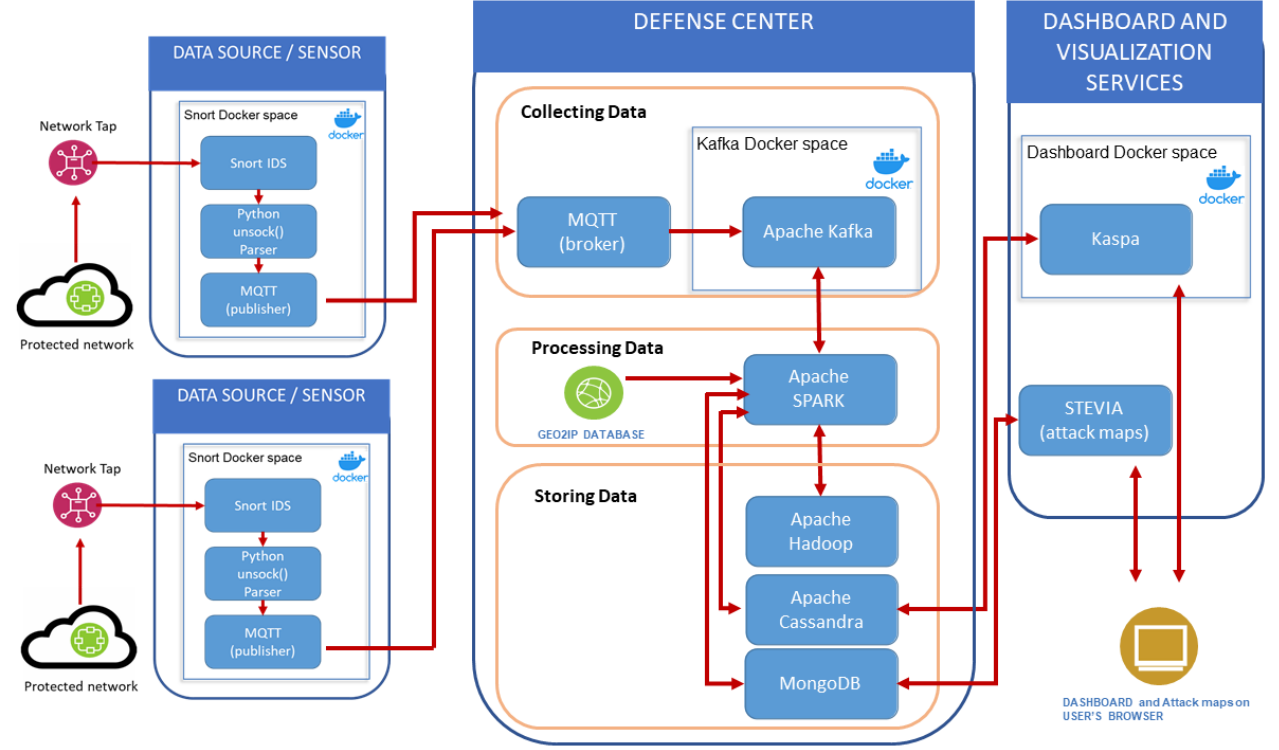
Figure 6. The functional block diagram of the proposed NIDS and big data architecture for cloud.